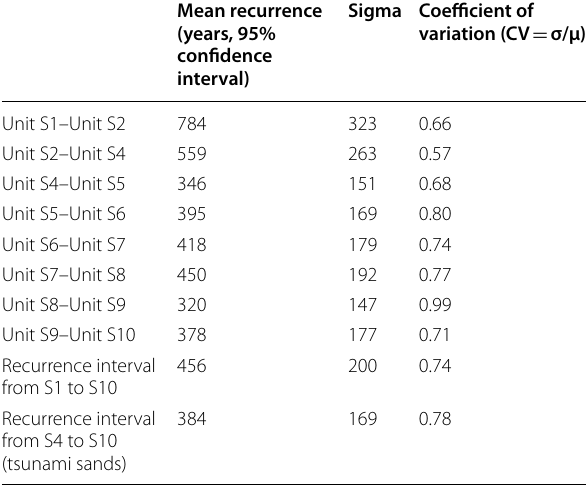
Table 5 Probabilistic recurrence between sand units